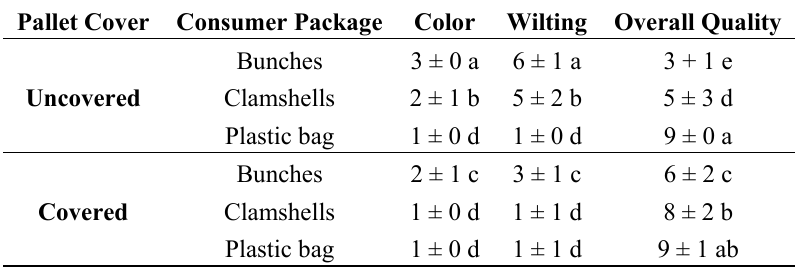
Table 7. Influence of pallet covers and consumer packages on color, wilting and overall quality of amaranth held for six hours under ambient